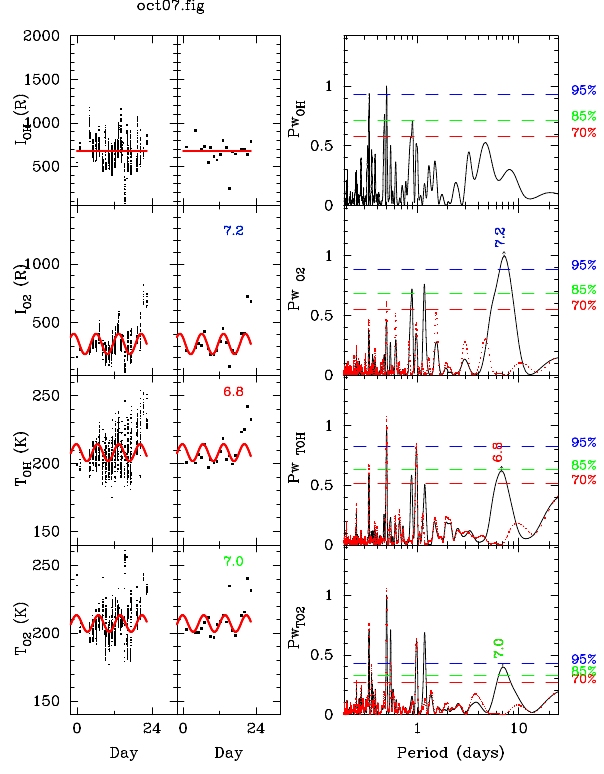
Fig. 1. Emission rates and rotational temperatures during October 2007. Left panel: Measurements. Solid line: Numerical calcula- tion. Middle panel: Nightly averaged measurements. Solid line: Numerical calculation. Right panel: Periodograms. Solid line: for time series measurements. Dotted and red line: for time series mea- surements after subtraction of the 7 day period detected